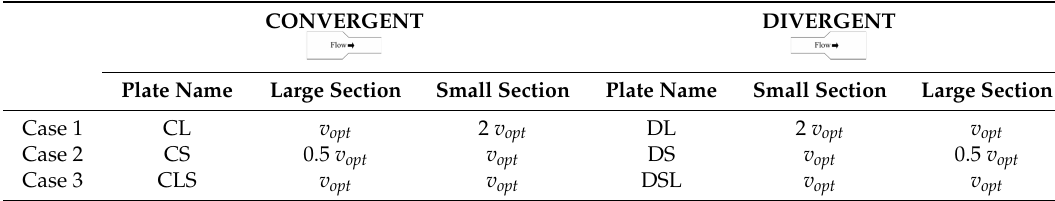
Table 4. Summary of the injection strategies considered during the manufacturing program. CONVERGENT DIVERGENT